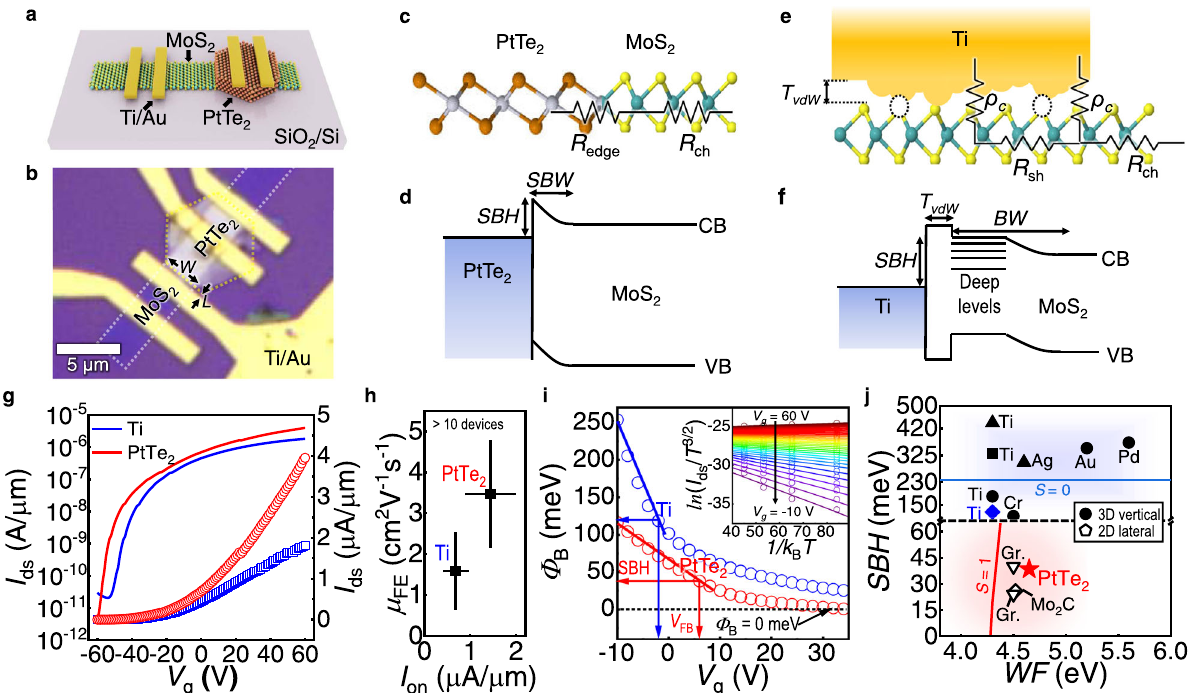
Fig. 2 | High performance of edge-contacted PtTe 2 -MoS 2 metal-semiconductor junction (MSJ) fi eld-effect transistors (FETs). a – h Monolayer MoS 2 FETs with asymmetric carrier injection from PtTe 2 lateral epitaxial contact and from vertical Ti, characterized at room temperature. a Schematic and ( b ) optical microscopy image of a device with asymmetric Ti/Au and PtTe 2 electrodes contacted to a monolayer MoS 2 (white dashed lines) with a de fi ned channel width ( W ) and length ( L ). c , e Cross-sectional illustrations of resistance networks of monolayer MoS 2 - basedMSJwith( c )atomicallystitchedPtTe 2 lateralcontactand( e )top-contactwith Ti/Au.MetallizationofMoS 2 candegradeboththecontactresistivity( ρ c )andsheet resistance ( R sh ) of MoS 2 . In contrast, the PtTe 2 -MoS 2 heterostructure has simpler resistance components, and the chemically derived edge resistance ( R edge ) is the only series resistance for the channel ( R ch ). d , f Comparison of band alignments with different Schottky barrier heights (SBHs) and Schottky barrier width (SBW) withrespecttotheMoS 2 conductionband(CB)andvalanceband(VB)edgesfor( d ) PtTe 2 -MoS 2 heterostructure and ( f ) conventional 3D metal-contacted MoS 2 . Tun- nelingbarrierformedbyvdWgapbetween Tiand MoS 2 ( T vdW ) anddefect-induced